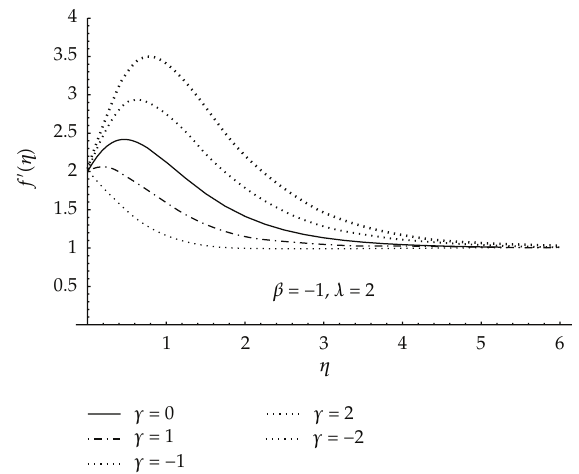
Figure 3: Velocity profiles for suction/injection parameter γ (cid:8) 1 , 0 , − 1 for λ (cid:8)